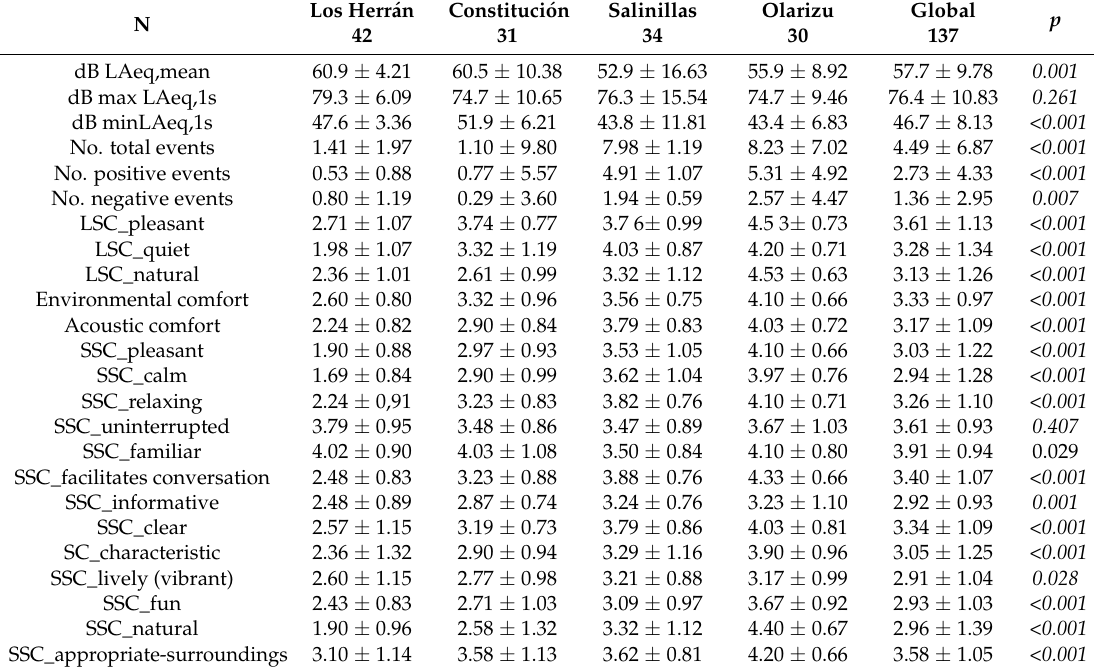
Table 3. Characterisation of the urban places analysed (mean scores ± standard deviation), by sound environment, landscape, environmental comfort and soundscape, and significance ( p ) of ANOVA